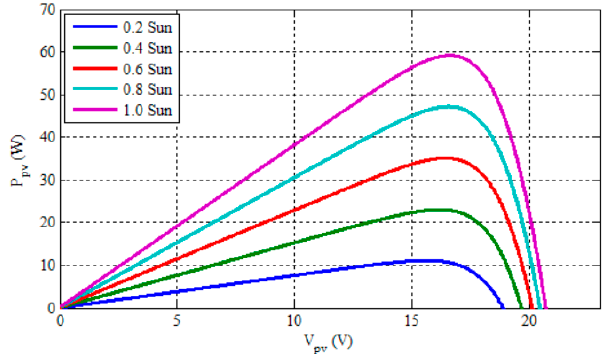
Figure 23. P-V Characteristics with varying irradiance.